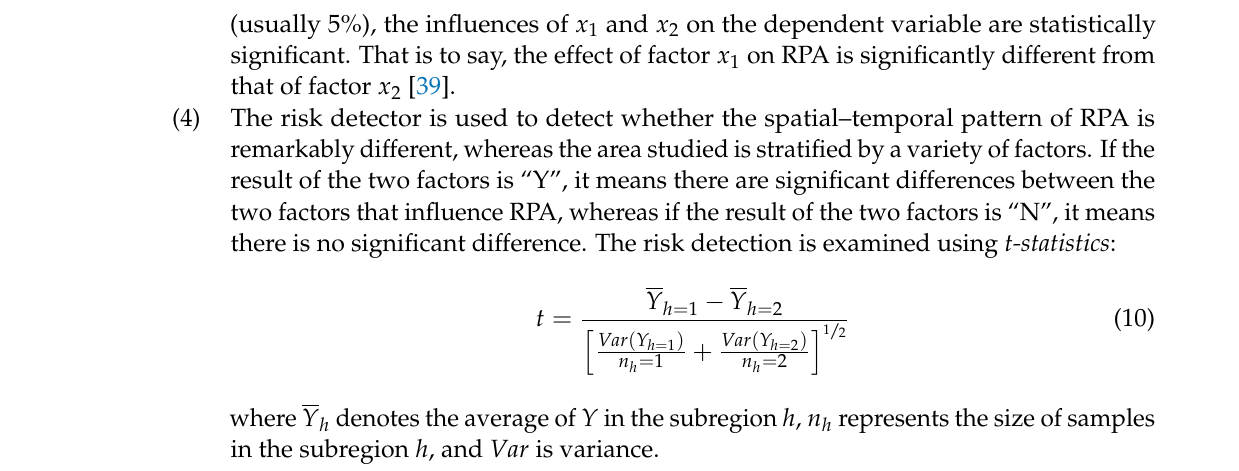
Table 2. The interaction types of two factors and the interactive relationship.